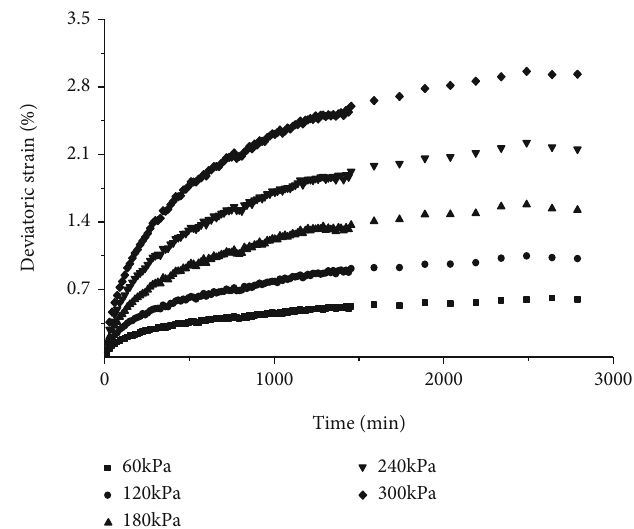
Figure 7: Deviatoric strain creep curve of reconstituted soil.